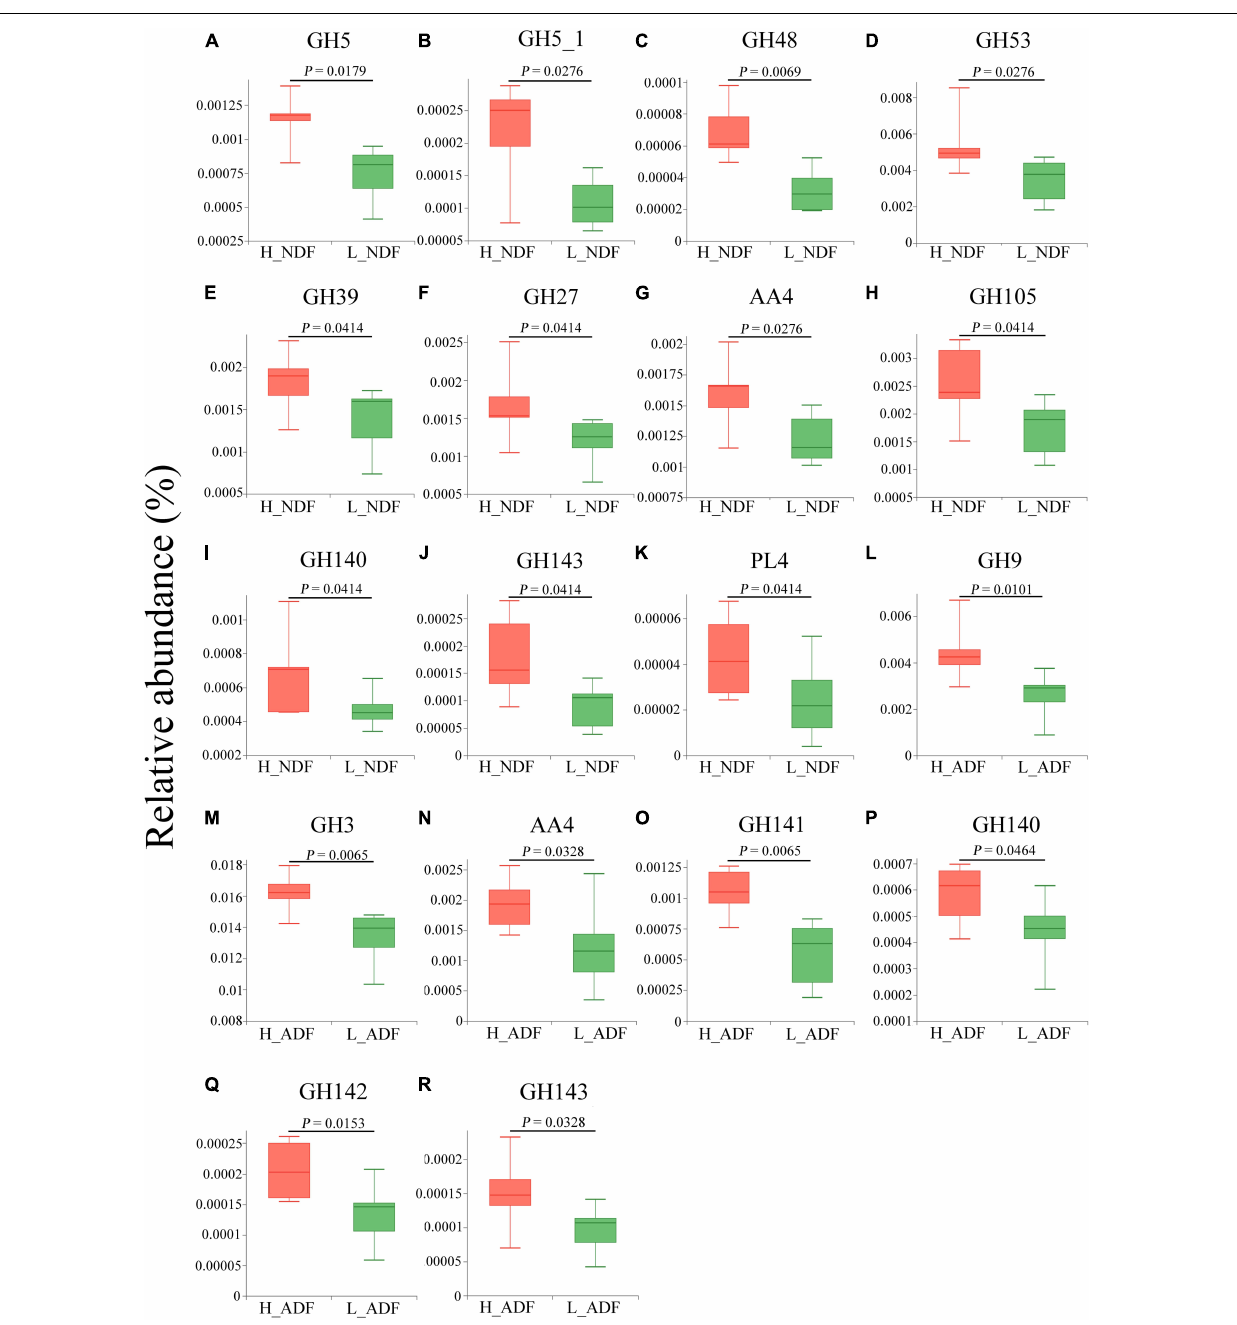
FIGURE 5 | Tested the difference of CAZy families between H_NDF and L_NDF groups and H_ADF and L_ADF groups by Wilcoxon rank-sum test: (A–C) show the CAZy families were associated with the degradation of cellulose, (D–F) show the CAZy families were associated with the degradation of hemicellulose, (G) shows the CAZy families was associated with the degradation of lignin, (H–K) show the CAZy families were associated with the degradation of pectin. Tested the difference of CAZy families between H_ADF group and L_ADF group by Wilcoxon rank-sum test: (L,M) show the CAZy families were associated with the degradation of cellulose, (N) show the CAZy families was associated with the degradation of lignin, (O–R) show the CAZy families were associated with the degradation of